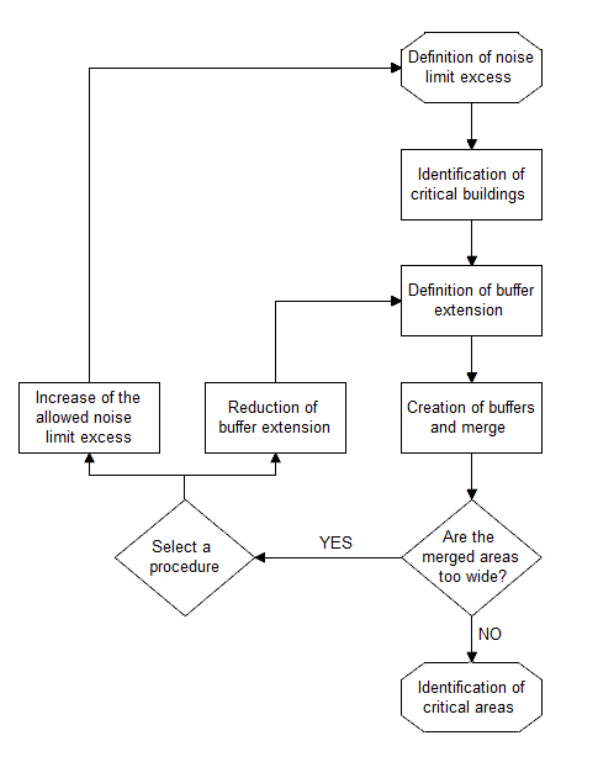
Figure 6: Flowchart for the identification of critical